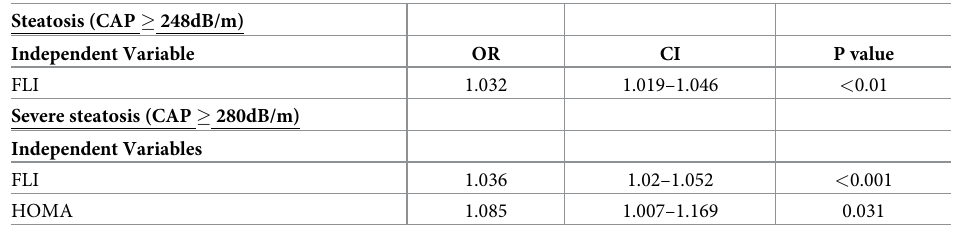
Table 6. Multivariate Logistic Regression analysis of variables associated with steatosis and severe steatosis. Steatosis (CAP (cid:21) 248dB/m)